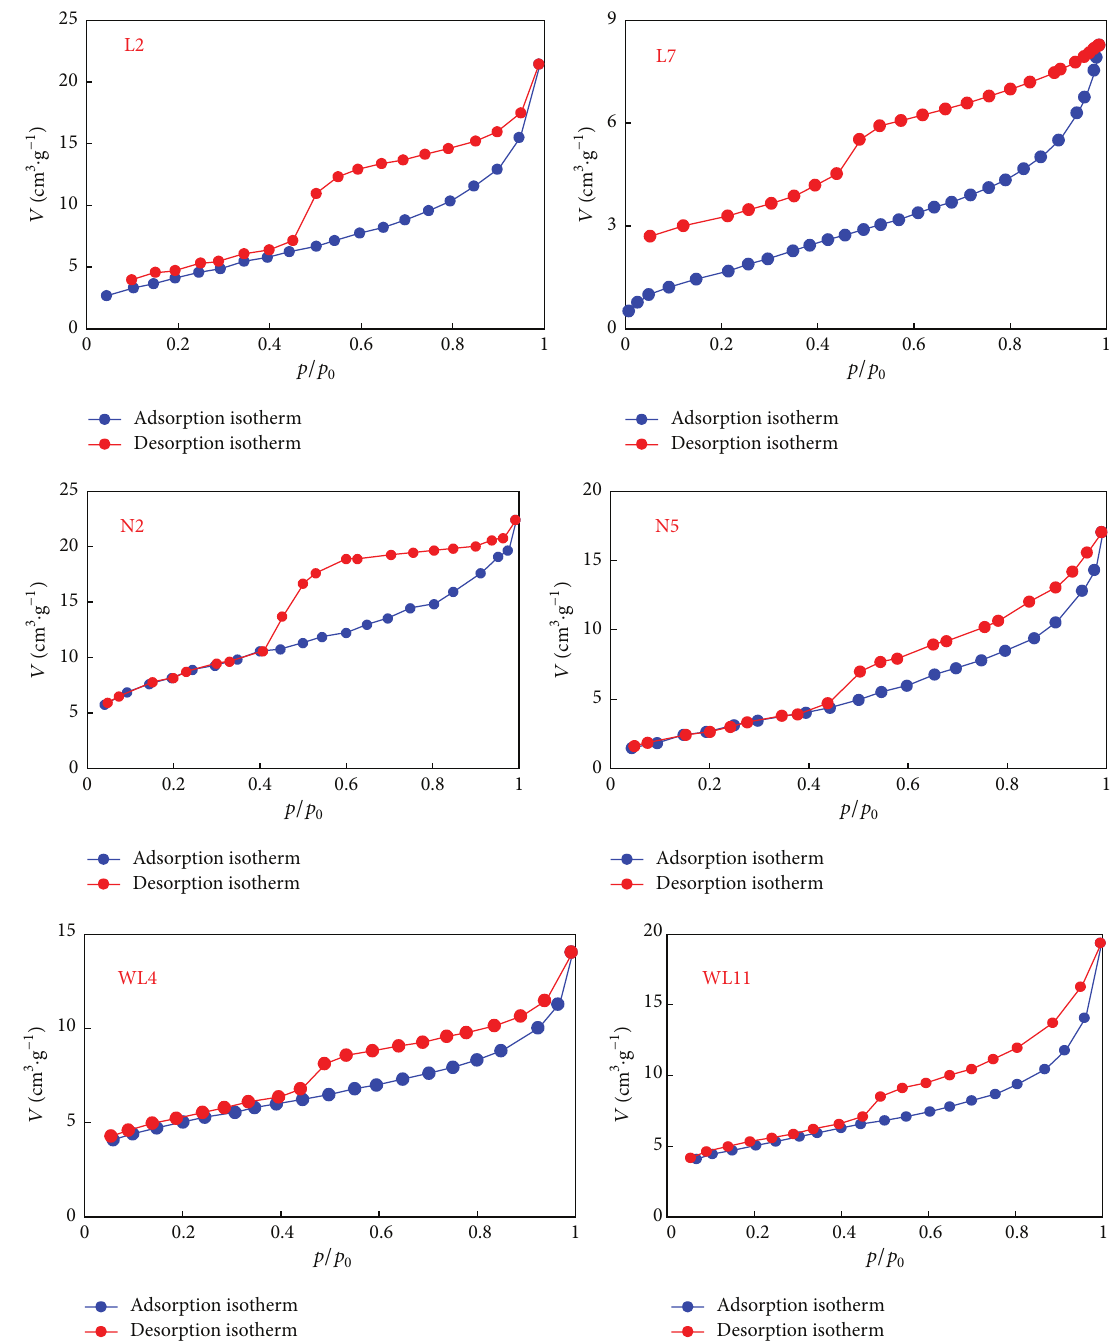
Figure 1: Low-pressure N 2 adsorption-desorption isotherms of some shale